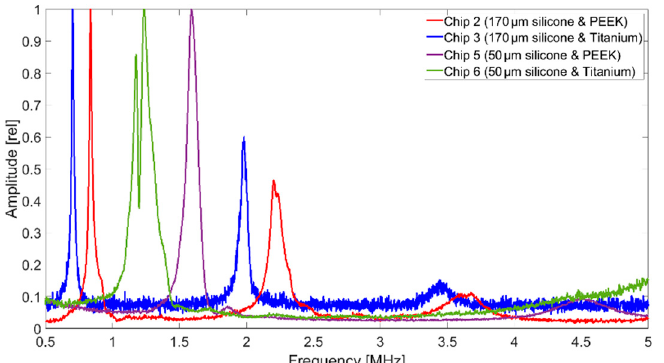
Figure 9. Frequency spectra by vibrometry of silicone and foil-coated CMUT chips in air, 60 V DC , 15 V AC , single sinusoidal burst at 3 MHz.